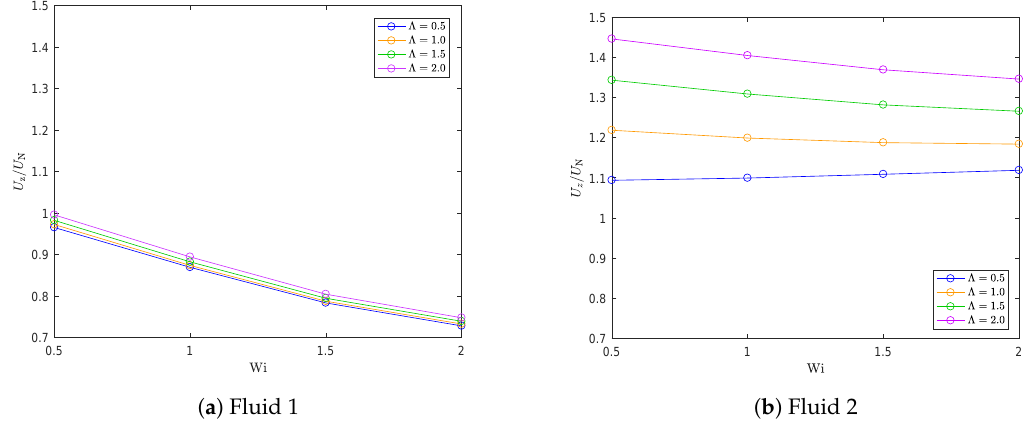
Figure 11. Sedimentation velocity as a function of Wi for increasing Λ for Fluid 1 and Fluid 2.